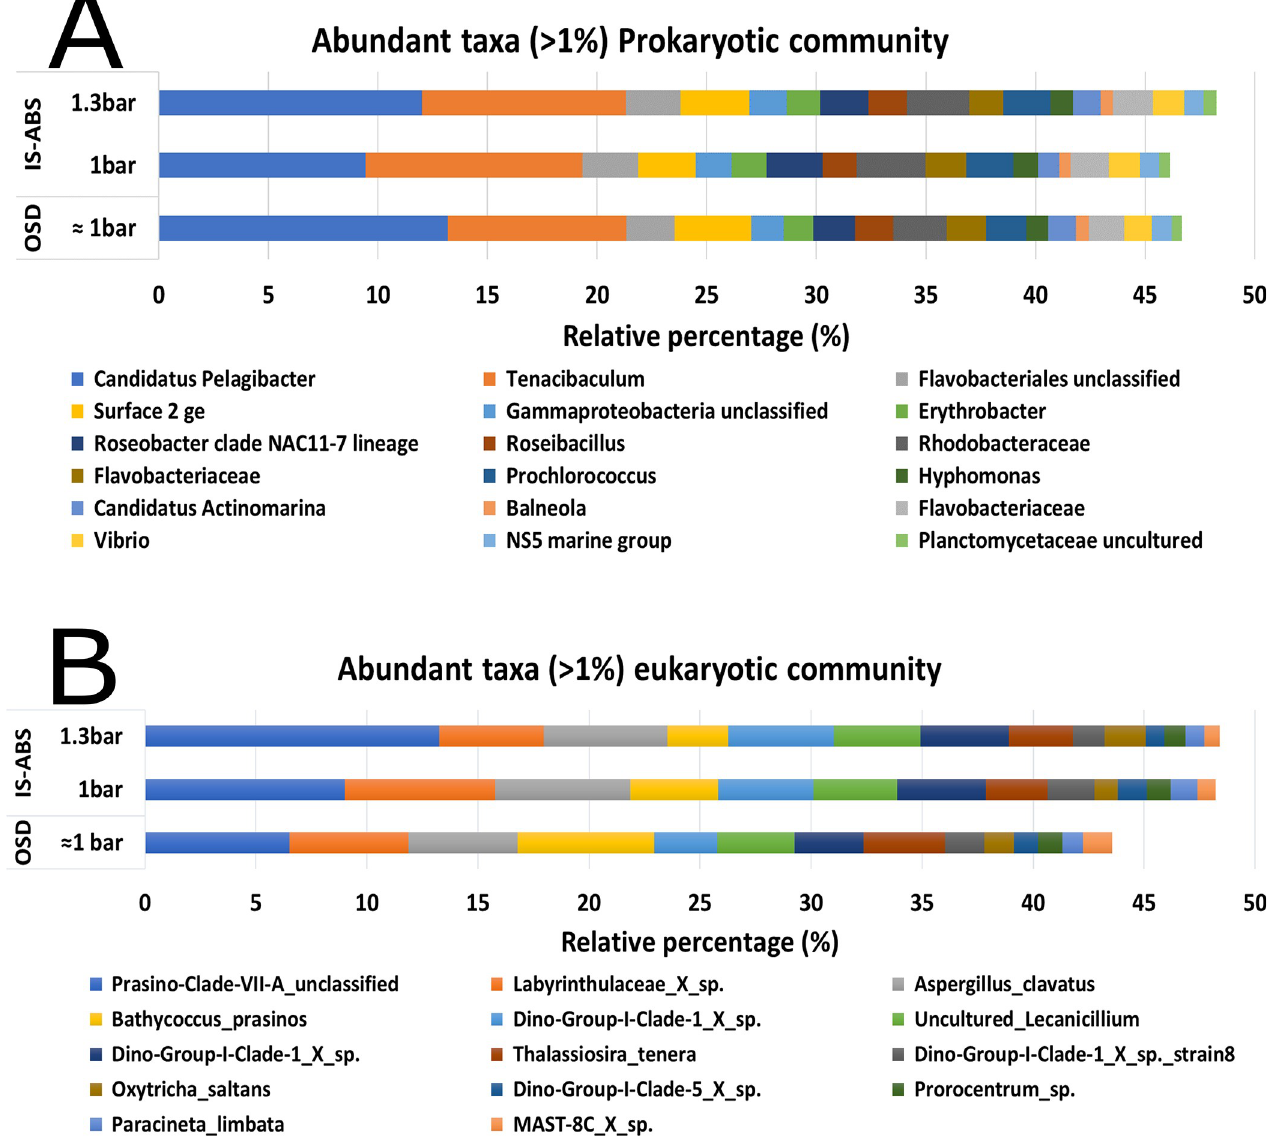
Fig 11. Distribution of the abundant taxa ( > 1%) retrieved from the 16S rDNA (A) and 18S rDNA (B) OTUs taxonomic composition at lower taxonomic level. Detected in the testes performed with the Ocean Sampling Day (OSD) standard procedure and with the autonomous biosampler (IS-ABS) (mean ± standard deviation, n = 3). For IS-ABS two filtration pressures were selected (1 and 1.3 bar). No significant differences (ANOVA, P � 0.05) were observed among the three filtration procedures for the relative percentage of each